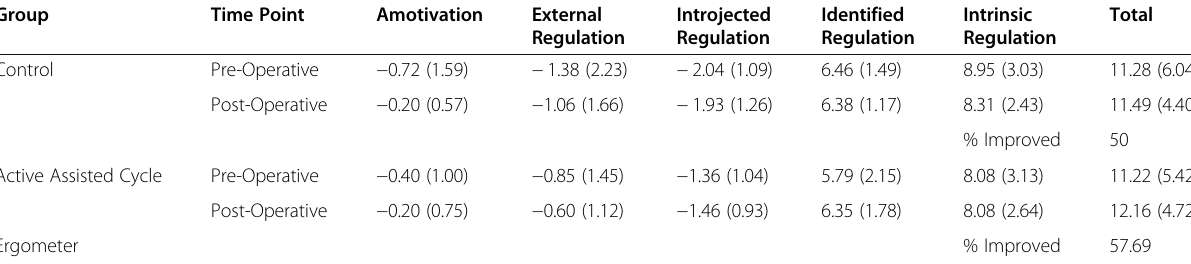
Table 2 BREQ2 pre-op and post-op measures. Results presented as average (SD). n = 24 – 26 per group